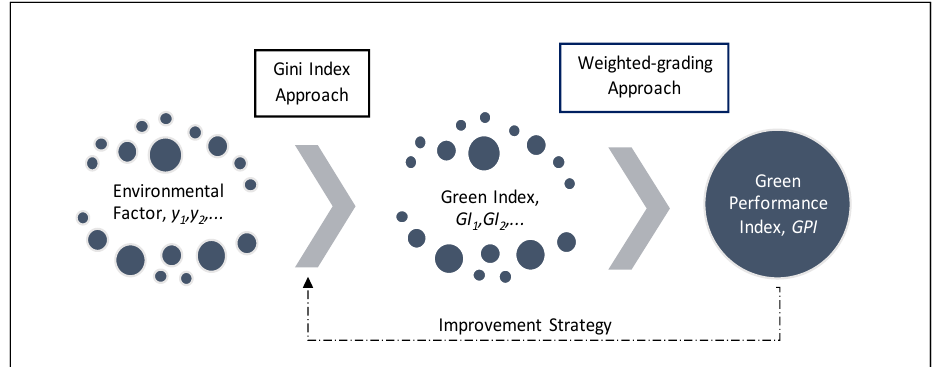
Fig. 1. The assessment framework of Green Performance Index (GPI).